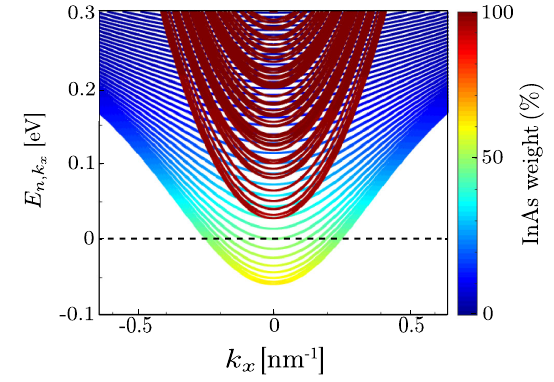
FIG. 9. Hybrid band structure for an Al-InAs nanowire with a square 100 × 100 nm 2 InAs cross section. The band structure is obtained after imposing confinement along one of the planar directions (e.g., y ). The parameter values are the same as in Fig. 3(e). The confinement leads to a “ splitting ” of the original bands shown in Fig. 3(e), thus resulting into a finite number of channels which are shifted in energy but exhibit similar hybridi- zation profiles. We remark that, for presentation purposes, we have not included the confinement channels originating from purely metallic bands. Note also that we have neglected the possible electrostatic effects near the boundaries of the confined